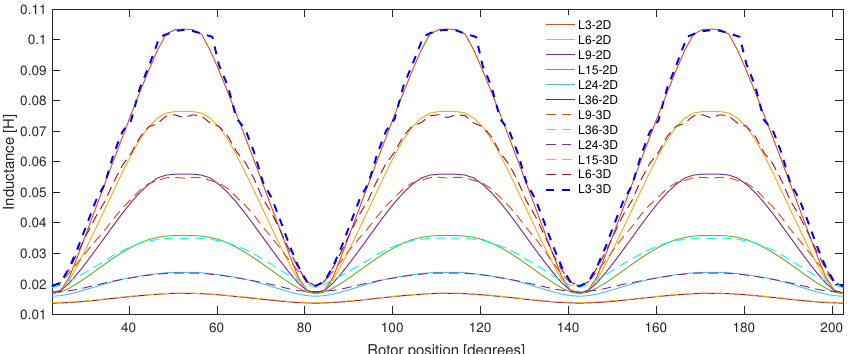
Figure 4. Self-inductance of the phase 1 for several excitation